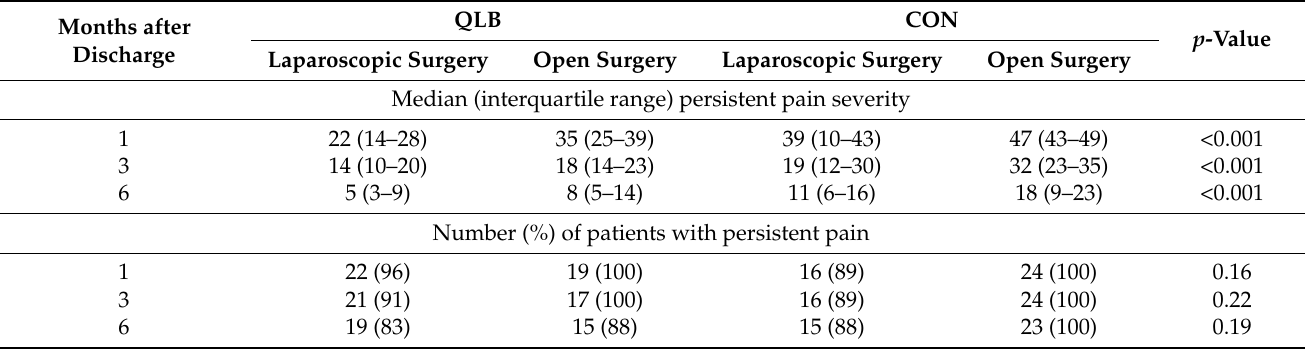
Table 6. Patients with chronic postoperative pain and pain severity measured with the NPSI by study group and surgery type.